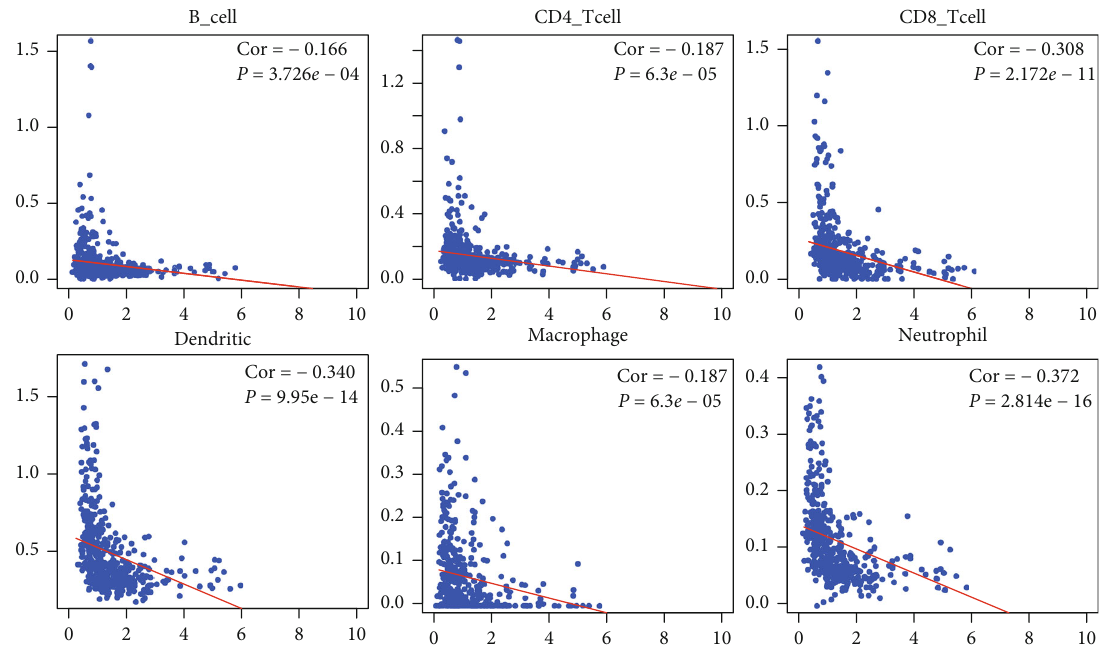
Figure 5: The relationship between 12 hub immune signatures/risk score and 6 tumor-in fi ltrating immune cells was evaluated using the TIMER database.